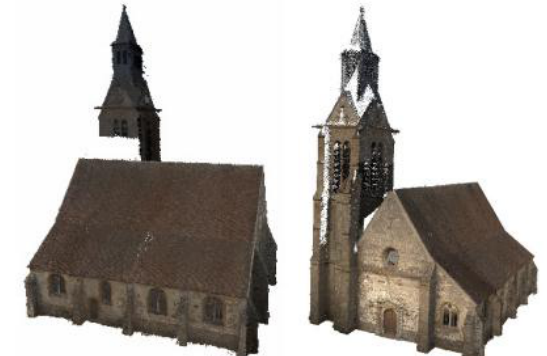
Figure 3: Superposition of point cloud of all master images